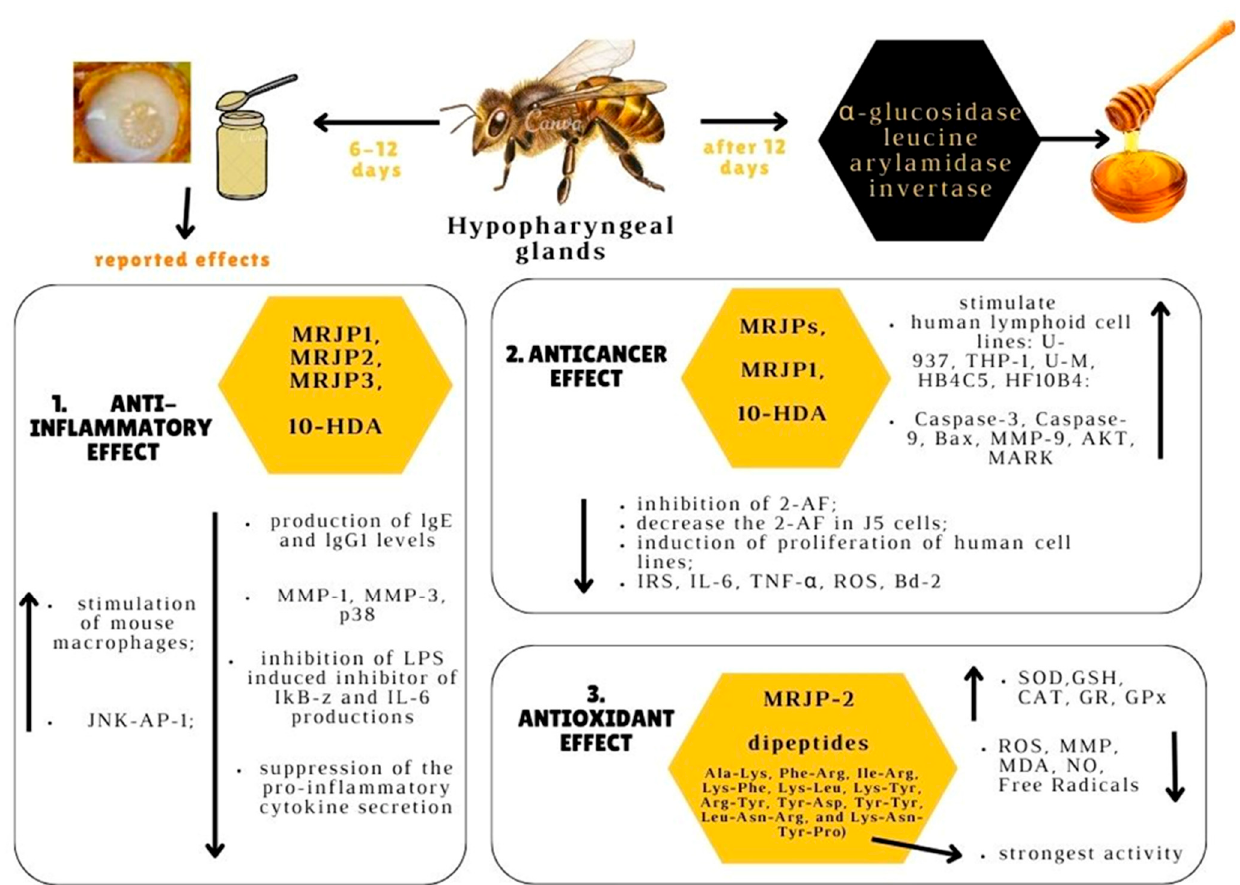
Figure 1. Anticancer, anti-inflammatory, and antioxidant effects of RJ and their mechanisms. RJ is produced by hypopharyngeal glands of bees with ages between 6–12 days. This bee product can be used for its effects: 1. Anti-inflammatory effect : increase in c-Jun N-terminal kinases-activating protein-1 (JNK-AP-1) and the stimulation of mouse macrophages; inhibition of lipopolysaccharide (LPS)-induced inhibitor of kappa-B-zeta (IkB-z) and IL-6 productions, inhibition the production of lgE and immunoglobulin lgG1 levels, inhibition of the activities of MMP-1, MMP-3, p38. 2. Anticancer effect: stimulation of growth of the following human lymphoid cell lines: U- 937, THP-1, U-M, HB4C5, HF10B4; increase in the activity of MMP-9 (matrix metallopeptidases-9), AKT (protein kinase B) and MAPK (mitogen-activated protein kinase); inhibition the metabolism of 2- aminofluorene (2-AF) metabolites in a human liver tumor cell line and decrease the 2-AF in J5 cells; induction of proliferation of human cell lines; decrease in IRS (insulin receptor substrate 1) activity; IL-4 (interleukin-4); TNF- α (tumor necrosis factor); ROS (reactive oxygen species). 3. Antioxidant effect: increase in SOD (superoxide dismutase), GSH (glutathione); CAT (catalase); GR (glutathione reductase), GPx (glutathione peroxidase) activities; and decrease in the levels of ROS (reactive oxygen species); MMP (matrix metallopeptidases), MDA (malondialdehyde), NO (nitric oxide), and free radicals (Created with canva.com, accessed on 17 January 2023).